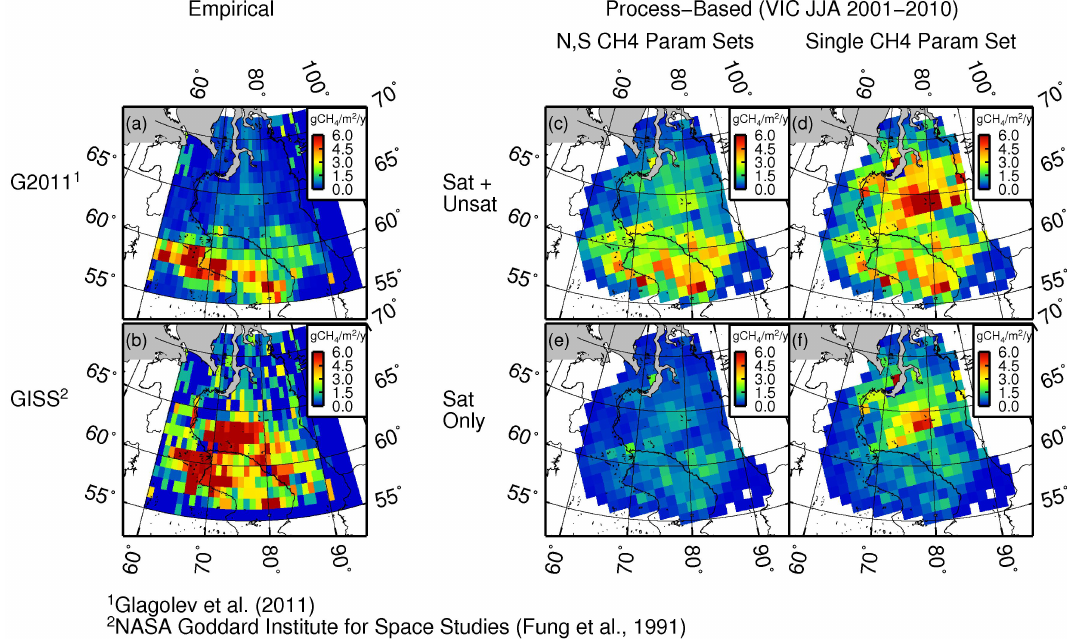
Fig. 7. Spatial distributions of various estimates of annual methane emissions per unit area of grid cell (wetland plus upland).